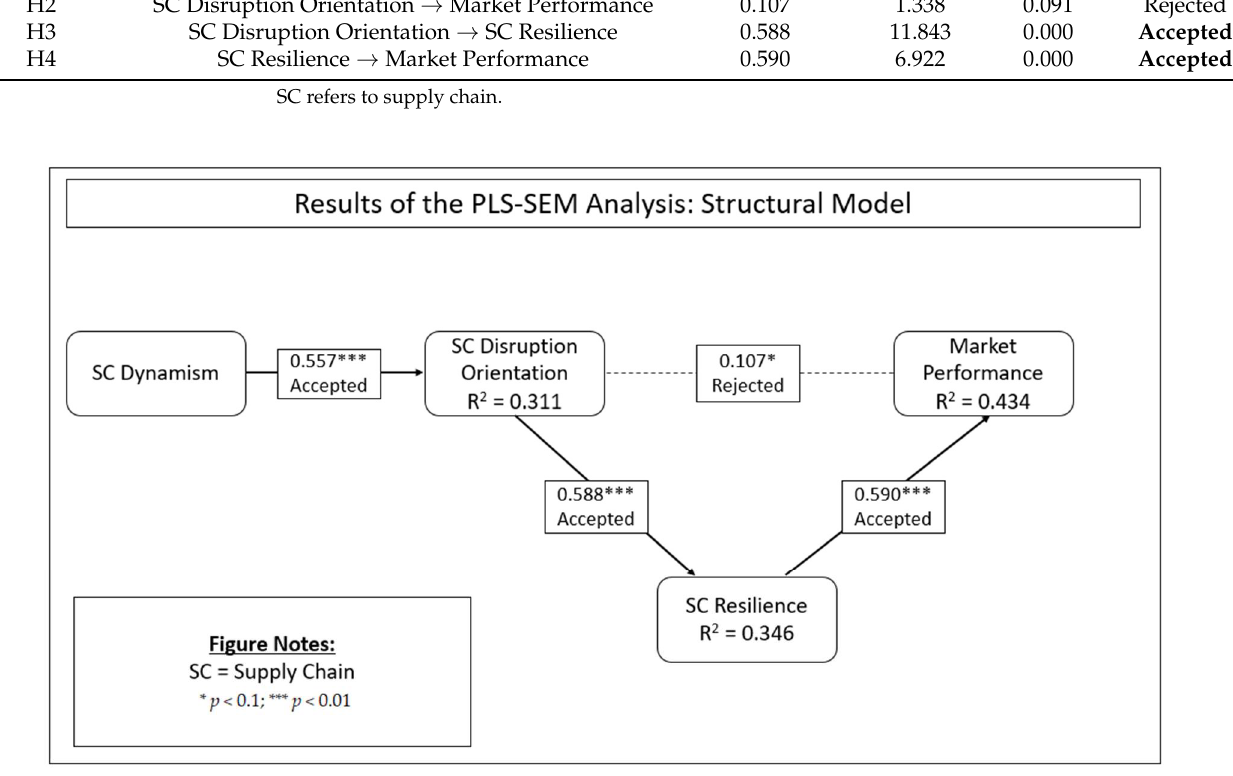
Table 7. Goodness-of-Fit.